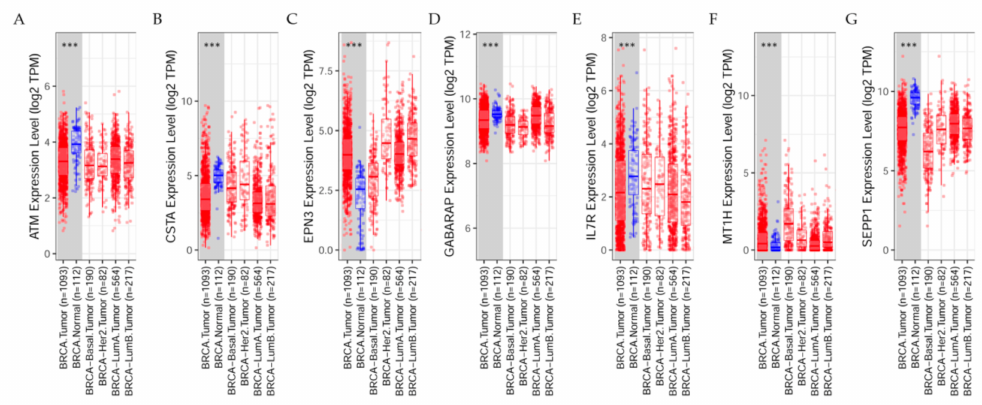
Figure 7. The differential gene expression levels between tumors and adjacent normal tissues. ( A ) ATM gene expression in breast tissues derived from basal, Her2, LumA, and LumB breast tissues; ( B ) CSTA, ( C ) EPN3, ( D ) GABARAP, ( E ) IL7R, ( F ) MT1H, and ( G ) SEPP1 in tumor tissues derived from basal, Her2, LumA, and LumB breast. ***: p -value <